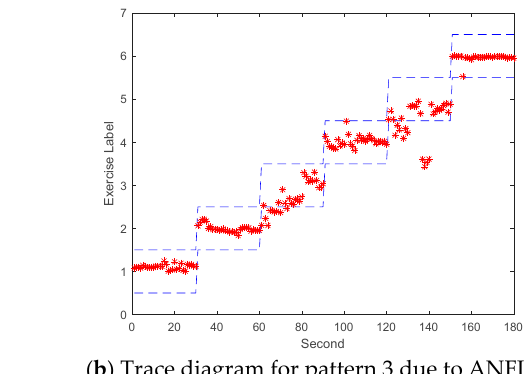
( a ) Trace diagram for pattern 12 due to SVM. ( b ) Trace diagram for pattern 3 due to ANFIS. Figure 7. The examples for subject B’s traceable diagrams due to the SVM and ANFIS models with the diverse feature patterns: ( a ) SVM with pattern (12), ( b ) ANFIS with pattern (3)